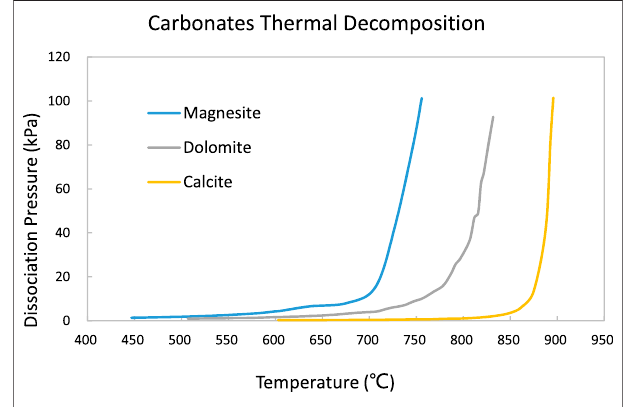
FIGURE 2 | Carbonates thermal decomposition. After (Mitchell,